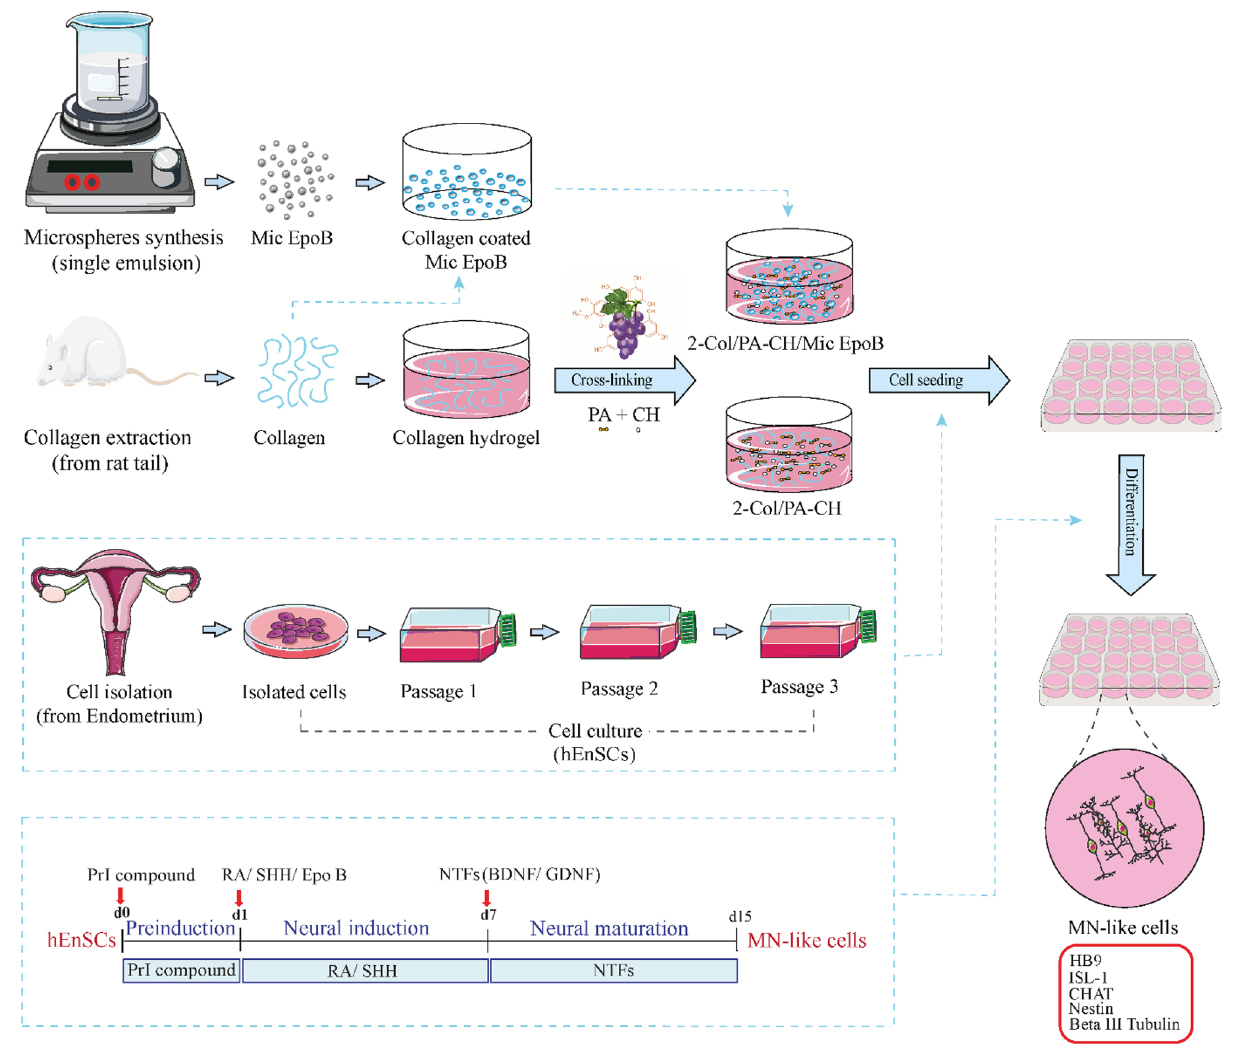
Figure 1. A schematic presentation of different steps of the study, including; EpoB microspheres synthesis using single emulsion, collagen extraction from rat tail, synthesis of collagen hydrogel and its crosslinking using proanthocyanidin from grape seed and calcium hydroxide (PA-CH), cell isolation, and culturing from human endometrium, and a three-step MN-differentiation (during 15